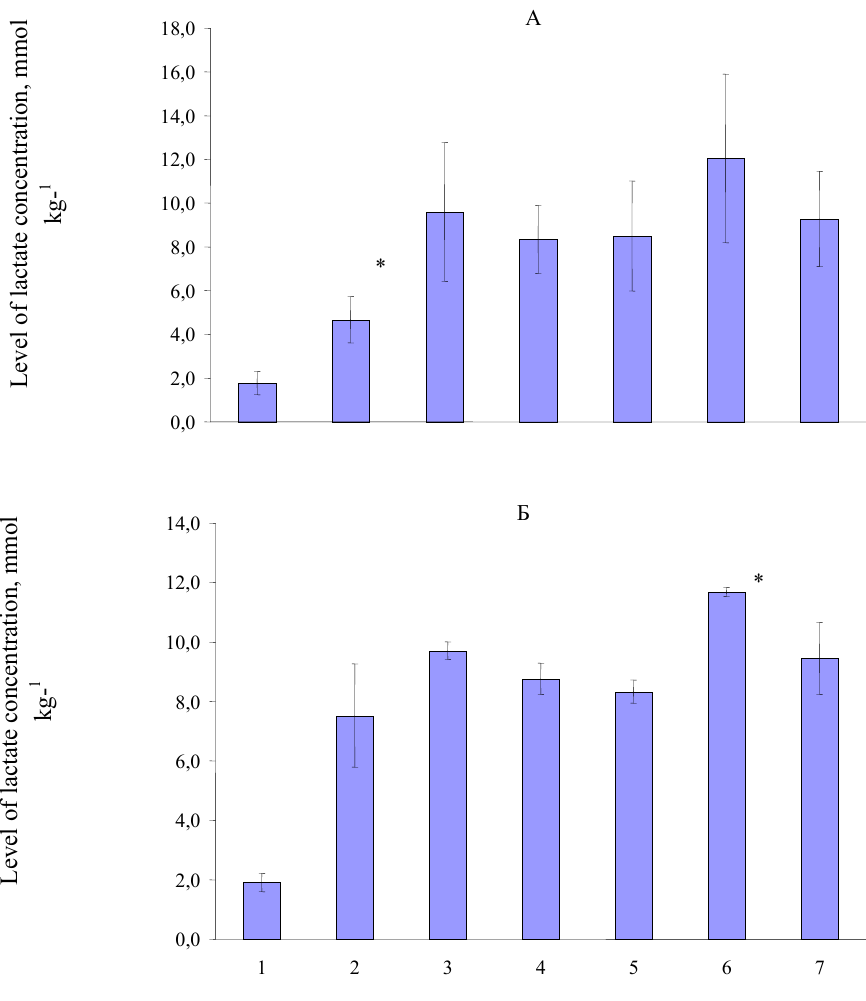
Fig 3. Change of lactate concentration in process of competition functioning’s simulation in semi-final and final; (А) men and (B) –